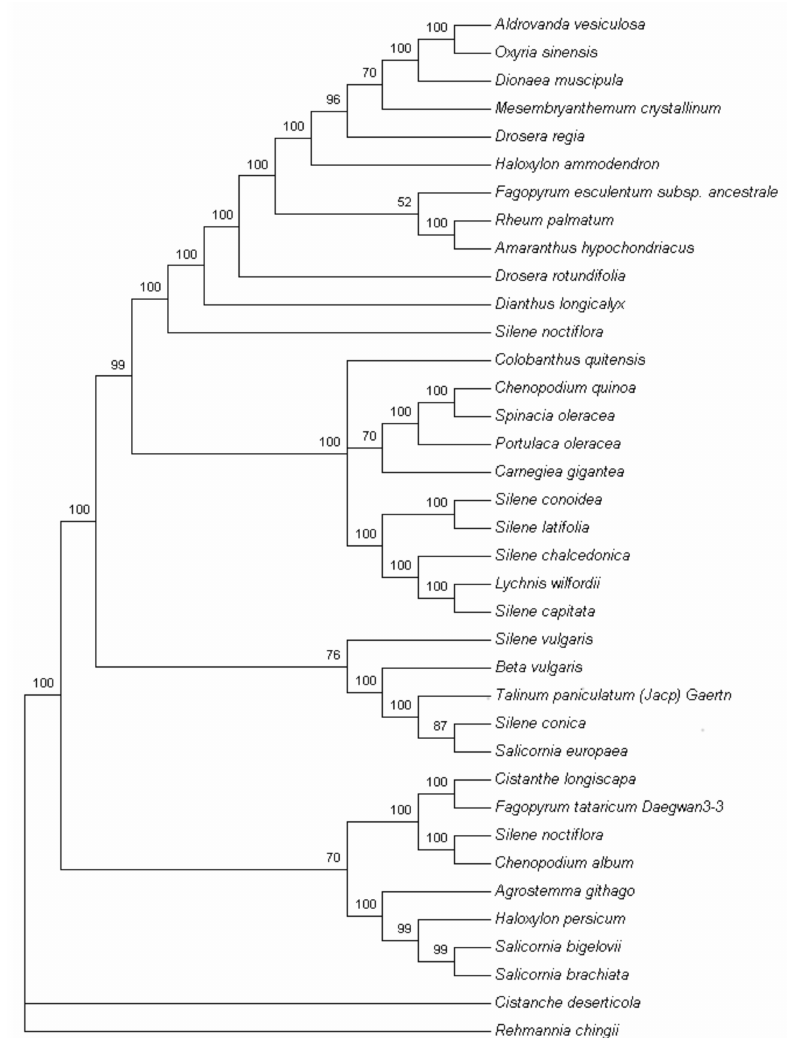
Figure 8. Phylogenetic tree of the 35 species in Caryophyllales using maximum parsimony (MP) and tree bisection-reconnection (TBR) analysis based on 48 protein-coding genes using a non-partitioning scheme. The phylogenetic tree was drawn using Cistanche deserticola and Rehmannia chingiis as